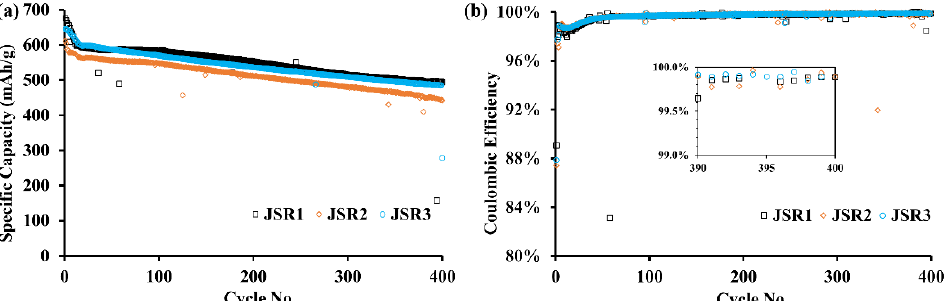
Figure 5. The cycling of performance of Si/C composite anodes using different SBR binders under C/3 (1C = 750 mA/g) with constant voltage during each discharge step (a) specific capacity and (b) Coulombic efficiency (insert shows the last 10 cycles).